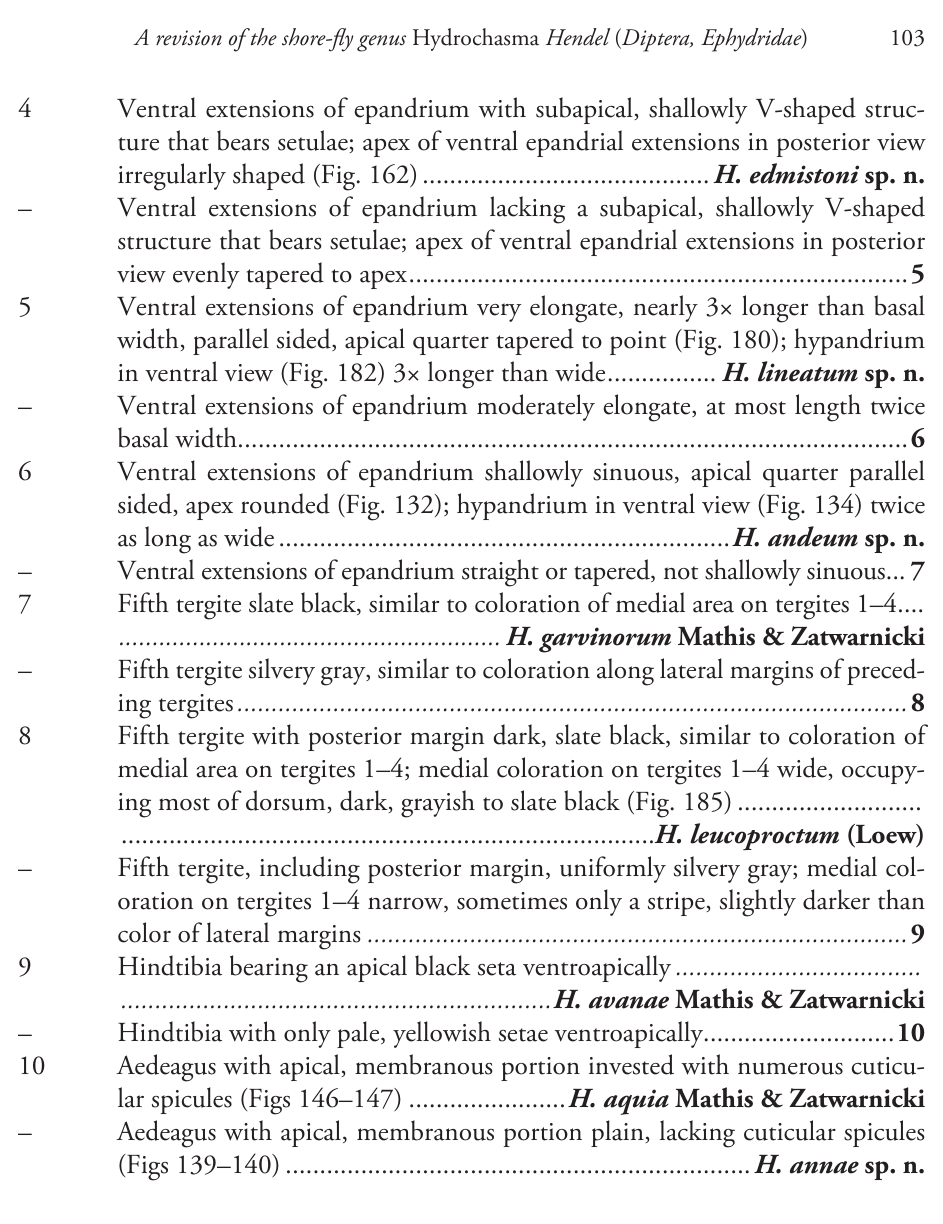
Diagnosis. This species is distinguished from congeners by the following combina- tion of characters: Small shore flies, body length 1.55–1.90 mm. Head: Subglobose, very broad ventrally, oral opening comparatively large; at least pedicel black,